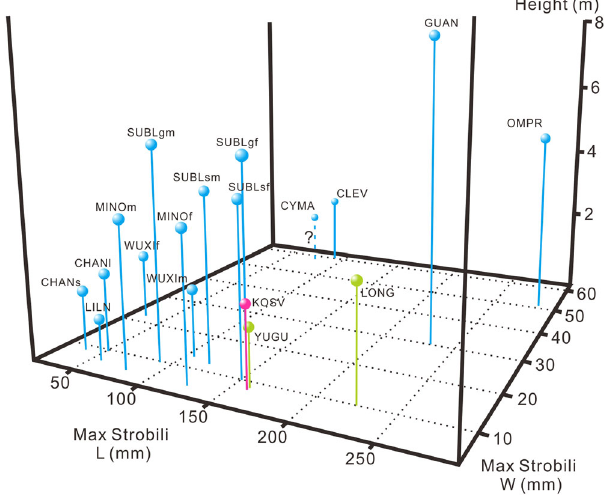
Fig. 6 3-D plot of the maximum strobilus lengths (mm), maximum strobilus widths (mm), and the calculated maximum plant height (m, according to Mosbrugger 53 ) of some representative Devonian lycopsids. Olivaceous, pink, and blue pins indicate the Givetian, Frasnian, and Famennian ages, respectively. Pin in dashed line with a question mark “ ? ” indicating unknown plant height. Data in this diagram according to Table 1.